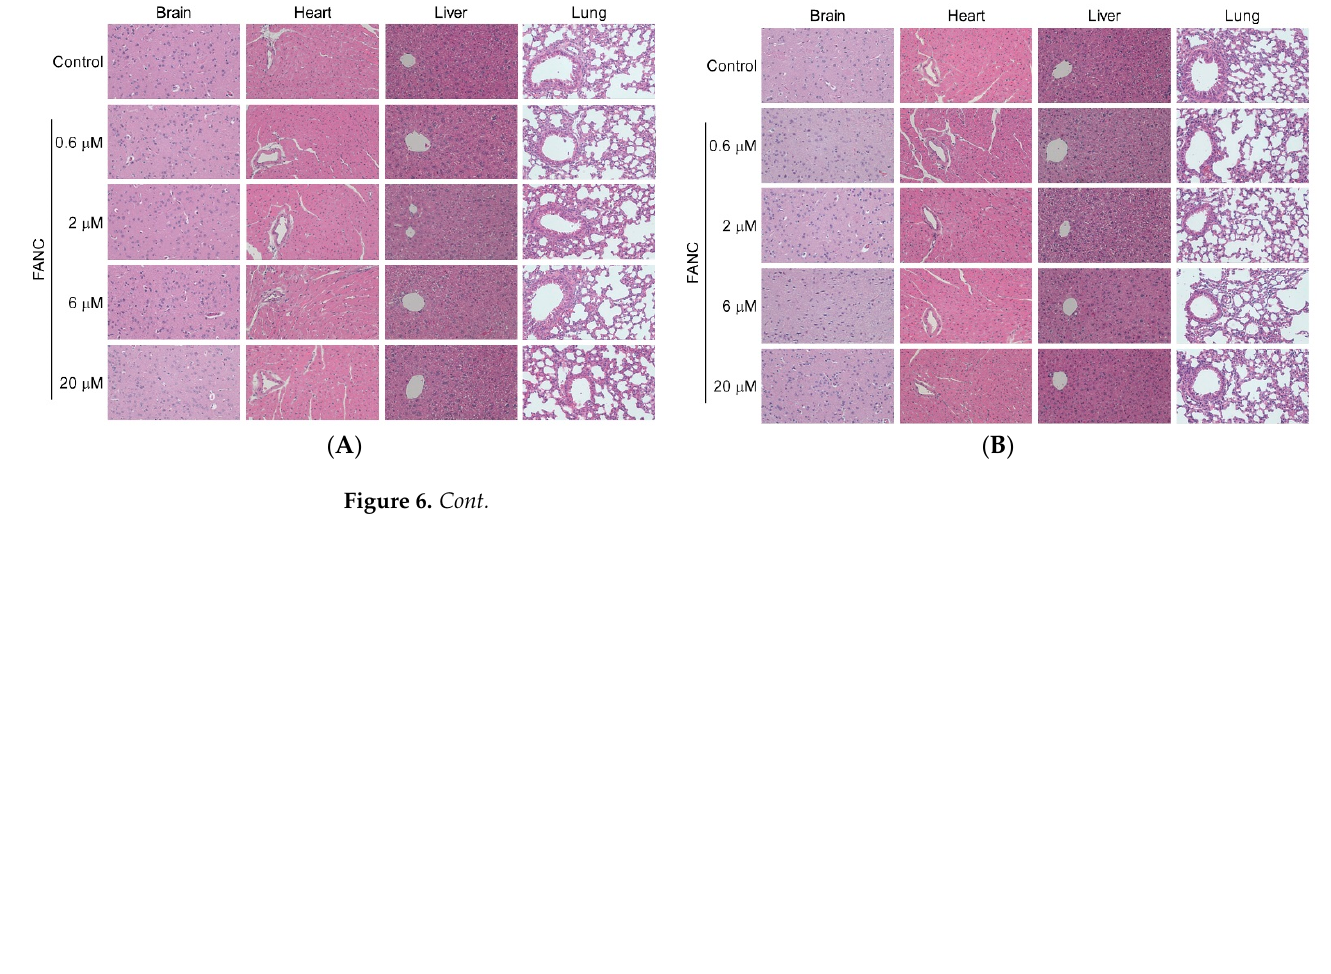
Figure 5. Organ coefficient changes of ICR mice with daily feeding of FANC for 14 days. Organ coefficient = (organ weight/body weight) × 100. Data are expressed as the mean ± SD ( n = 5).